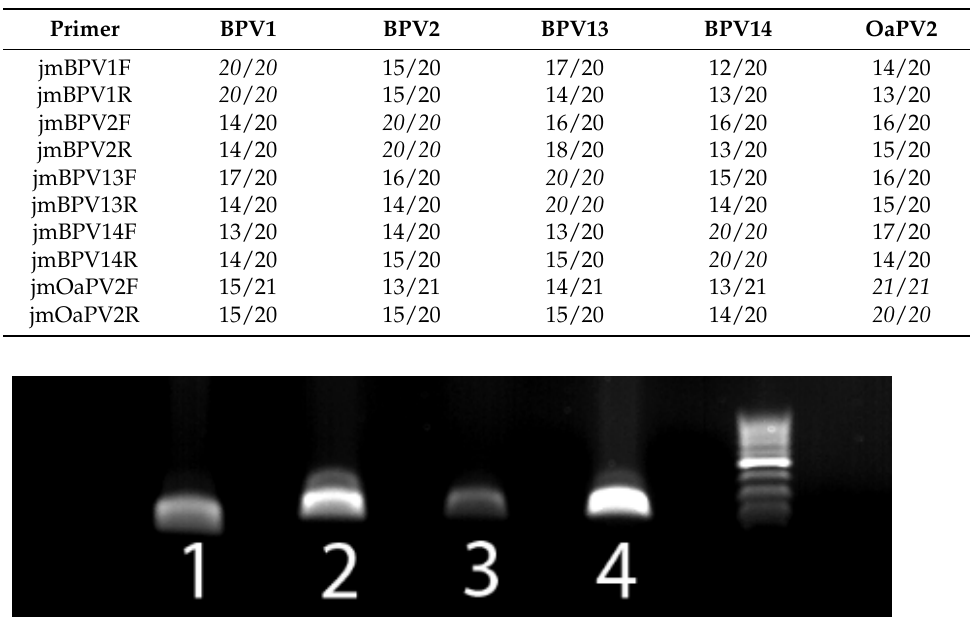
Figure 1. Photograph of a 1% agarose gel. Lane one is bovine papillomavirus (BPV) type 1 DNA amplified by the jmBPV1 primer set (111 bp). Lane two is BPV2 DNA amplified by the jmBPV2 primer set (198 bp). Lane 3 is BPV14 DNA amplified by the jmBPV14 primer set (195 bp). Lane 4 is Ovis aries papillomavirus type 2 DNA amplified by the jmOaPV2 primer set (219 bp). The DNA ladder contains bands at 100 bp increments, with the bright band an amplicon of 500